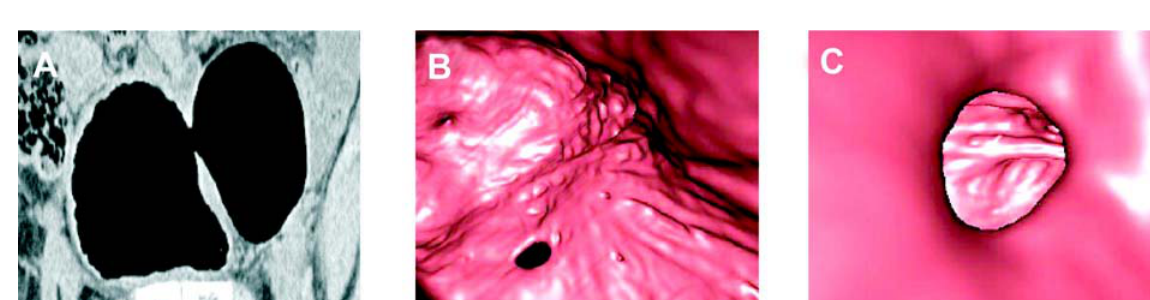
Figure 5 – 45 year-old men with virtual CT cystoscopic images of bladder wall diverticulum. A) Sagittal multiplanar reconstruction image. B) Virtual CT cystoscopy appearance of the neck of the diverticulum. C) Interior appearance of the diverticulum. Diverticulum could be evaluated both of the multiplanar reconstruction images and virtual CT cystoscopy, but could not in the conventional cystos-